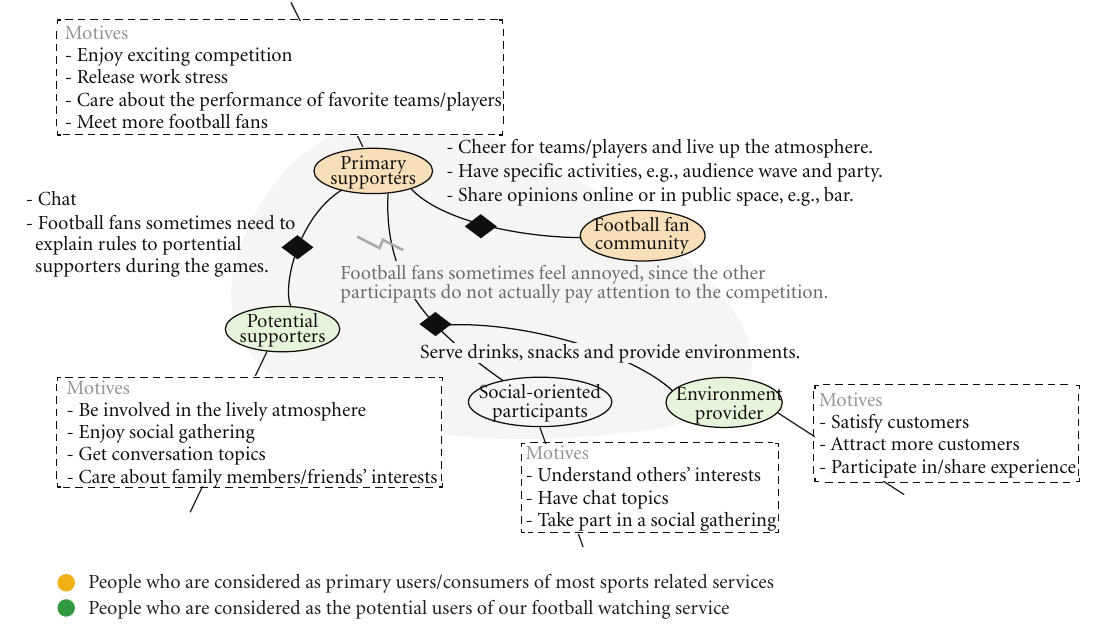
Figure 4: The multilevel social activity model of sport watching.